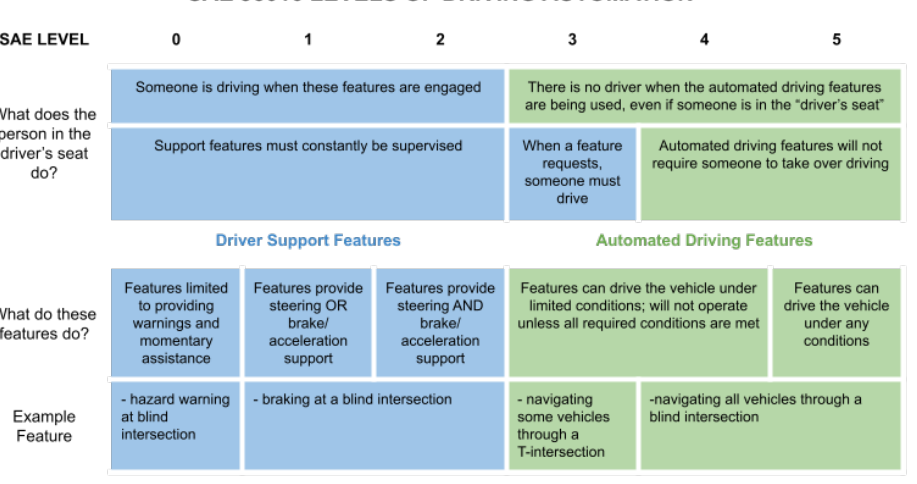
Figure 1. Levels of driving autonomy adapted from [1]. The example features are as related to the scenario of this